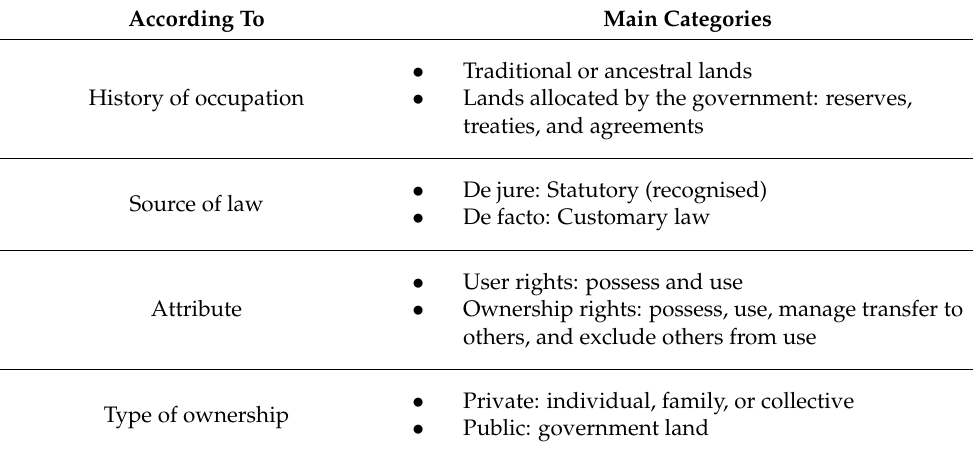
Table 1. Forms of classification of Indigenous land rights. According